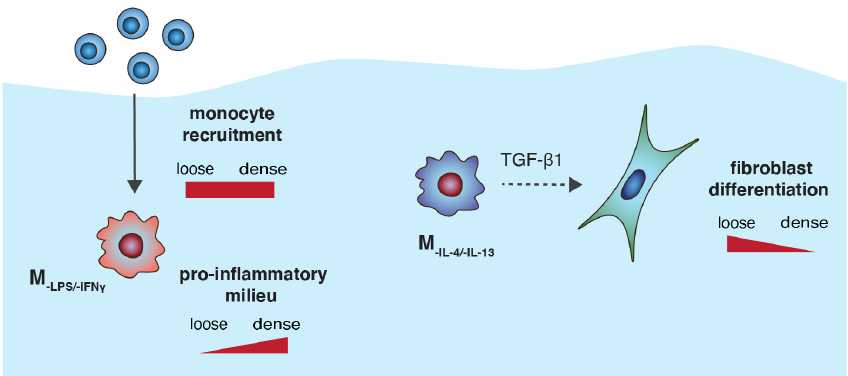
Figure 6. Schematic illustration of the effect of collagen fibril density regulating macrophage-associated functions in a tissue repair context.